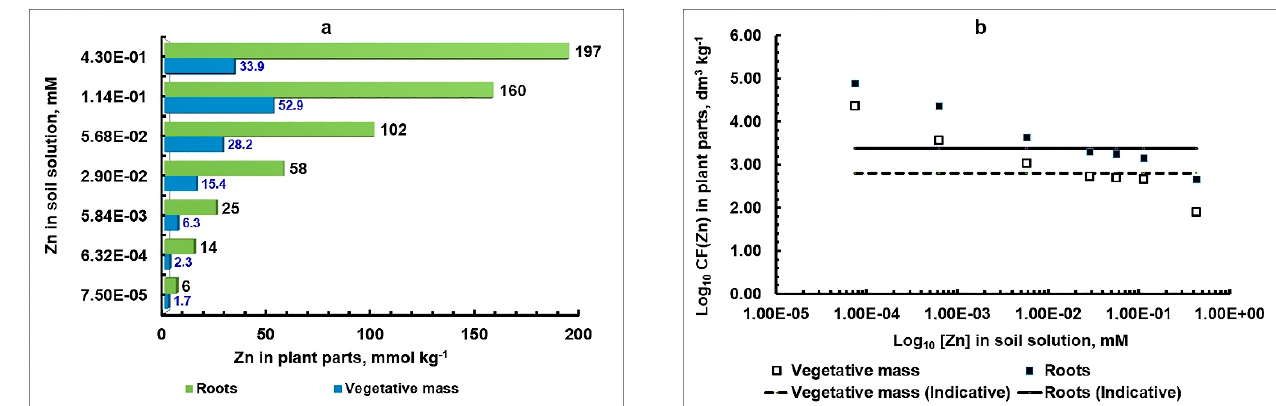
Figure 5. The relationship between the concentration of Zn in the soil solution and its content in different parts of 21-day-old barley plants (in terms of dry biomass) ( a ); values of CF Zn,roots and CF Zn, VPs , expressed for clarity in logarithmic form ( b ). Straight lines denote constant values in the “indicative” region CF Zn,roots = 2375 and CF Zn, VPs = 640 dm 3 kg − 1 .